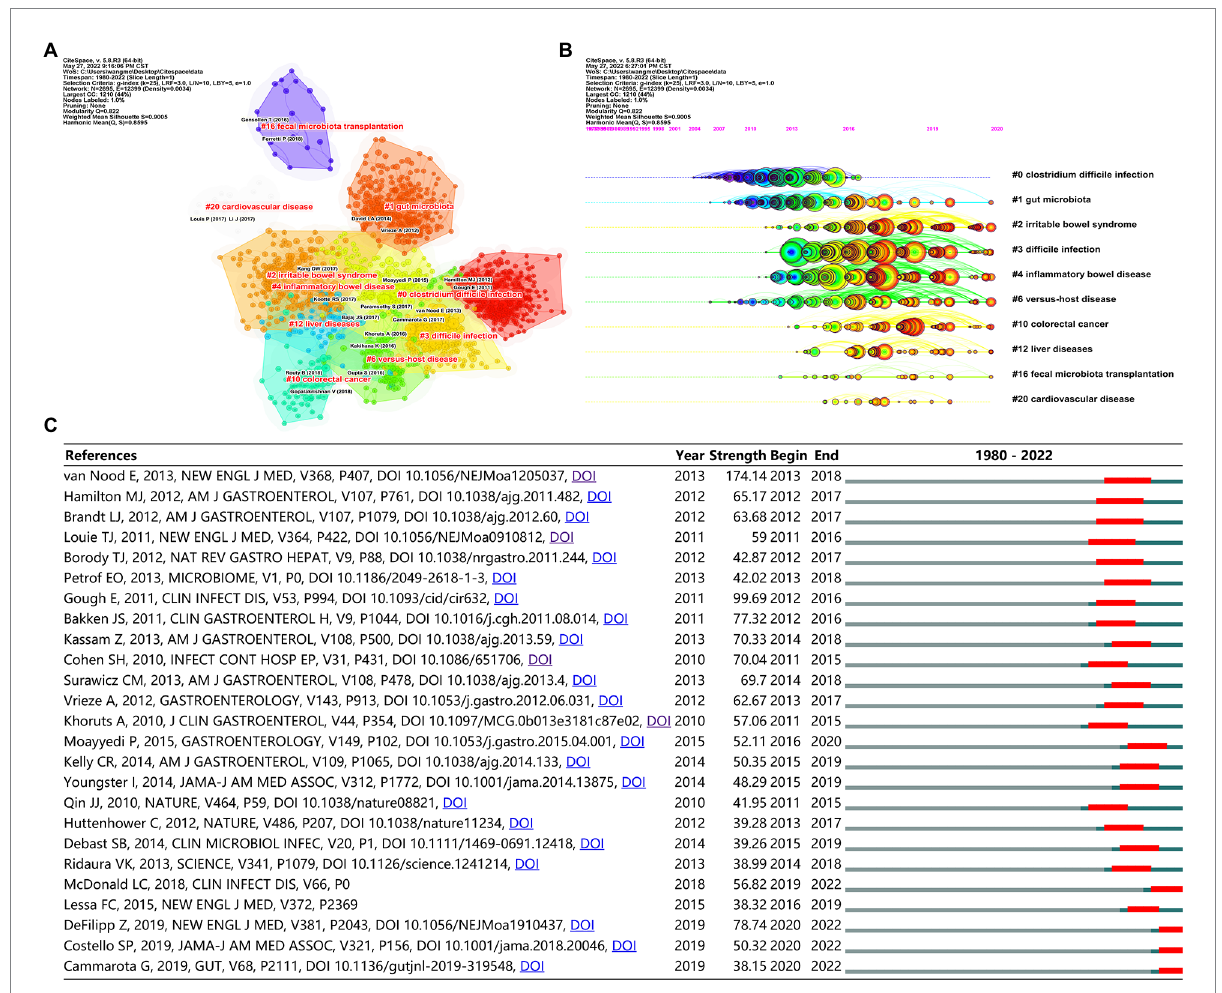
FIGURE 7 Co-cited references analysis. (A) The 10 major clusters of references. Each circle represents a reference, and circles with the same color represent a cluster with the same topic. (B) Timeline view of the 10 major clusters. Each circle represents a reference, and the circle on the same line represents a cluster with the same topic; The position of each circle represents the time when it was first cited, and the size of the circle represents the total number of it was cited. Each colored circle (tree ring history) represents the citations in a single time slice. (C) The top 25 references with the strongest citation bursts. The “Strength” represents the strength of citation bursts, the strength value is proportional to the